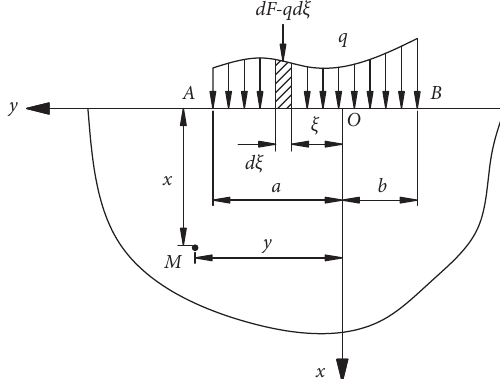
Figure 2: Distributed load on the boundary of semi-infinite